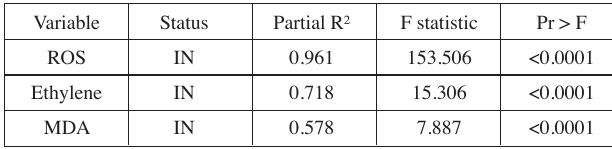
Tab. 3: Summary of variable selection using stepwise analysis showing at- tributes that contribute most to superficial scald severity of